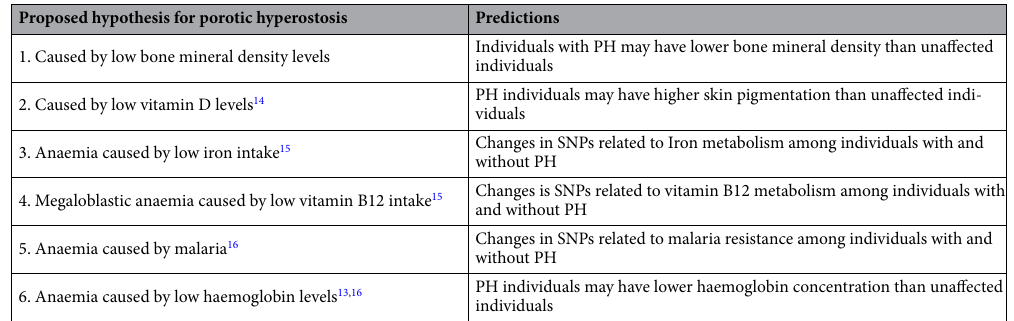
Table 1. Hypothesis and predictions for the origin of